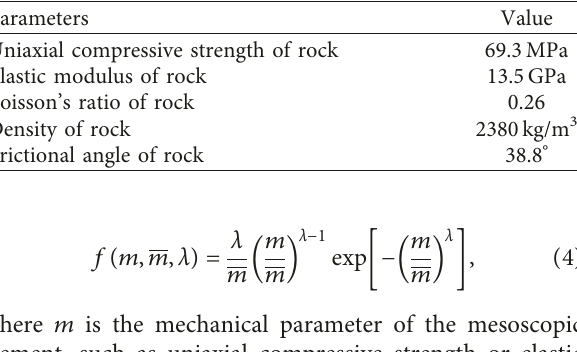
Table 1: Macromechanical parameters from the study of Lu et al. [13].